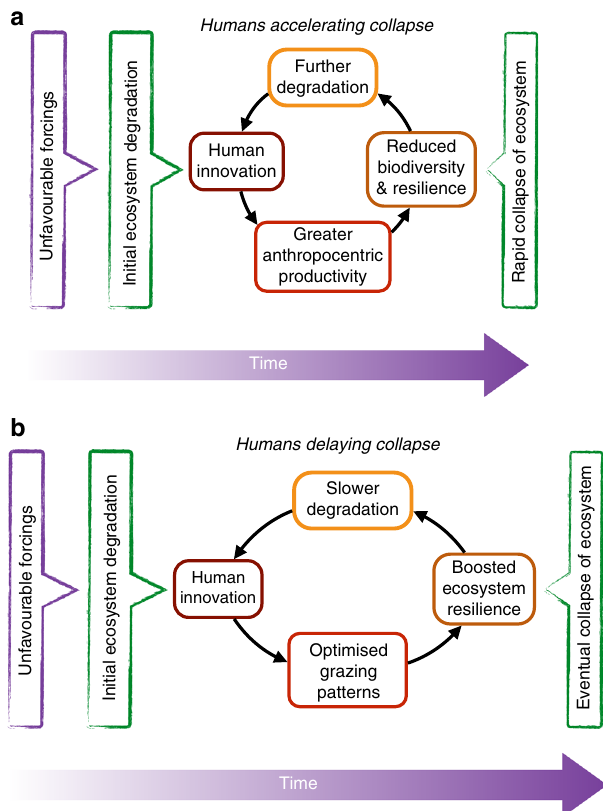
Fig. 1 Pastoralist – environment interactions. a Schematic of a human population expansion beyond the carrying capacity of the region exacerbating aridi fi cation 2 . b Schematic of how the technological and cultural advances associated with sustainable pastoralism could help buffer changes to a fragile